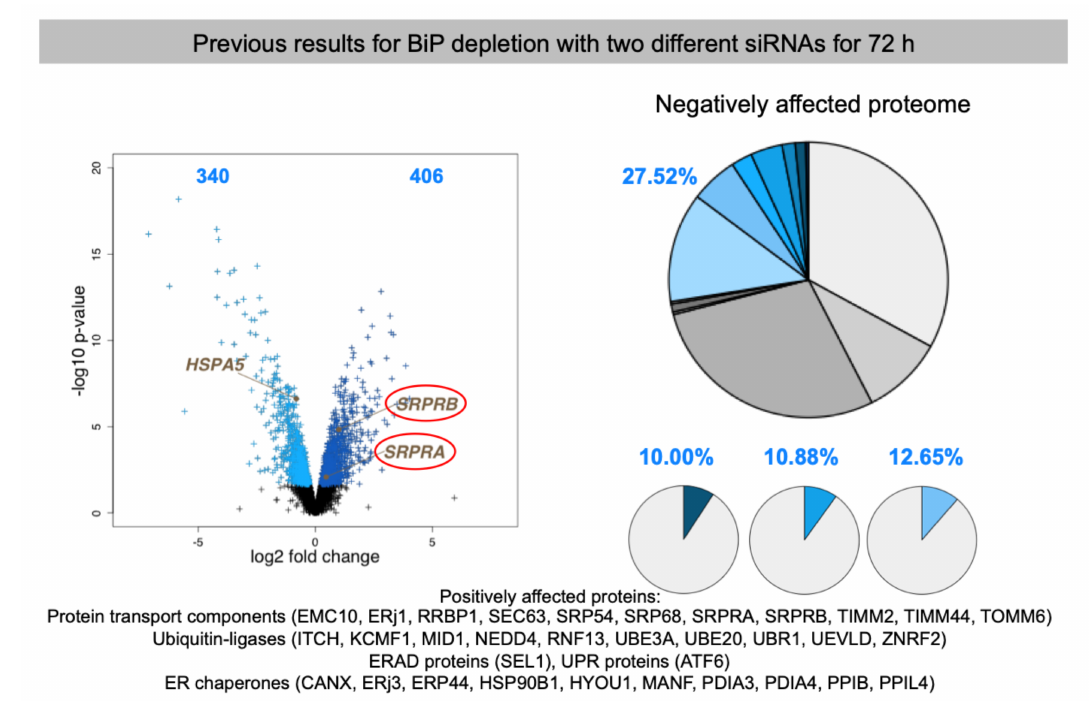
Figure 8. Representative volcano plot and GO enrichment after BiP depletion. Differentially affected proteins were characterized by the mean difference of their intensities plotted against the respective permutation false discovery rate- adjusted p -values in volcano plots. The representative results for a single targeting siRNA are shown on the left. BiP, which is coded by the HSPA5 gene, and subunits of the SRP receptor are highlighted in the plot. In addition, the numbers of proteins, which were negatively or positively affected in both experiments, are given; the full set of relevant positively affected proteins are given below. Classification of BiP clients was based on GO enrichment factors where the results from the complete set of quantified proteins (not shown) are compared with the negatively affected proteome. Protein annotations of signal peptides, membrane location, and N-glycosylation in humans were extracted from UniProtKB, and used to determine the enrichment of GO annotations among the negatively affected proteins. The figure summarizes results from a previous experiment and is shown here in modified form for comparison